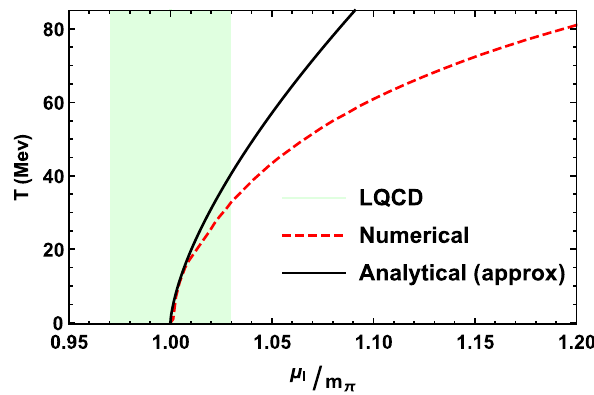
Fig. 3 Phase diagram of chiral perturbation theory at finite isospin chemical potential and temperature using the central values of param- eters. See main text for details is the analytical result of Eq. (71), and the green shaded area is the lattice QCD result of Refs. [16,17]. We observe that the red and black curves are in very good agreement for tem- peratures below 20 MeV. However, beyond this point there is a significant deviation between the curves, suggesting that the analytical result breaks down rather quickly. While the approximation (μ I − m π ) (cid:9) T holds quite well along the black curve displayed in Fig. 3 the second approximation T (cid:9) m π breaks down somewhere in the lower part of